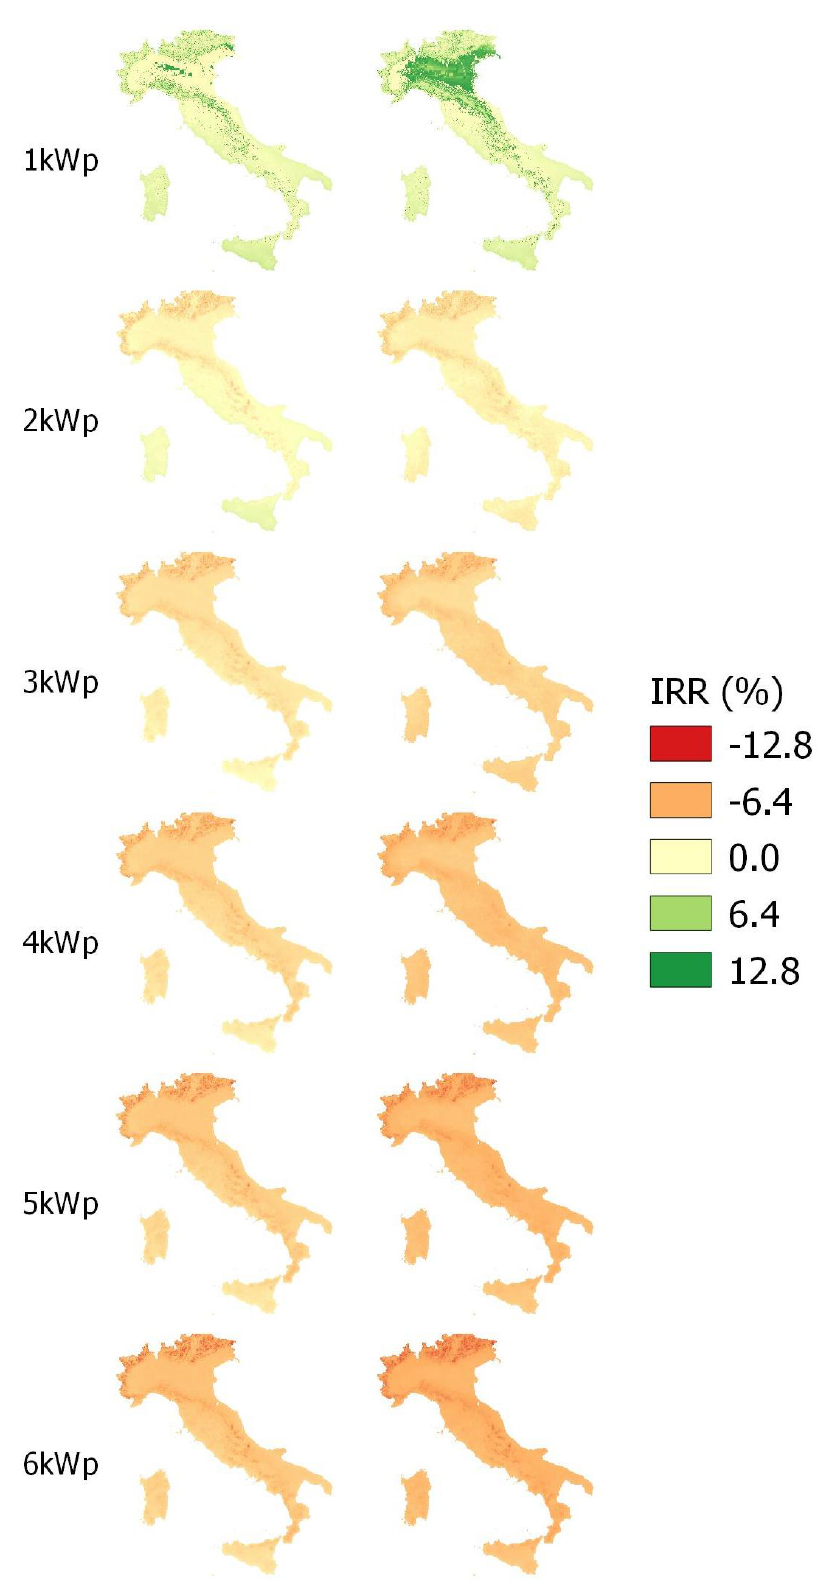
Figure A4. IRR for E L = 2700 kWh, left side without battery and right side with